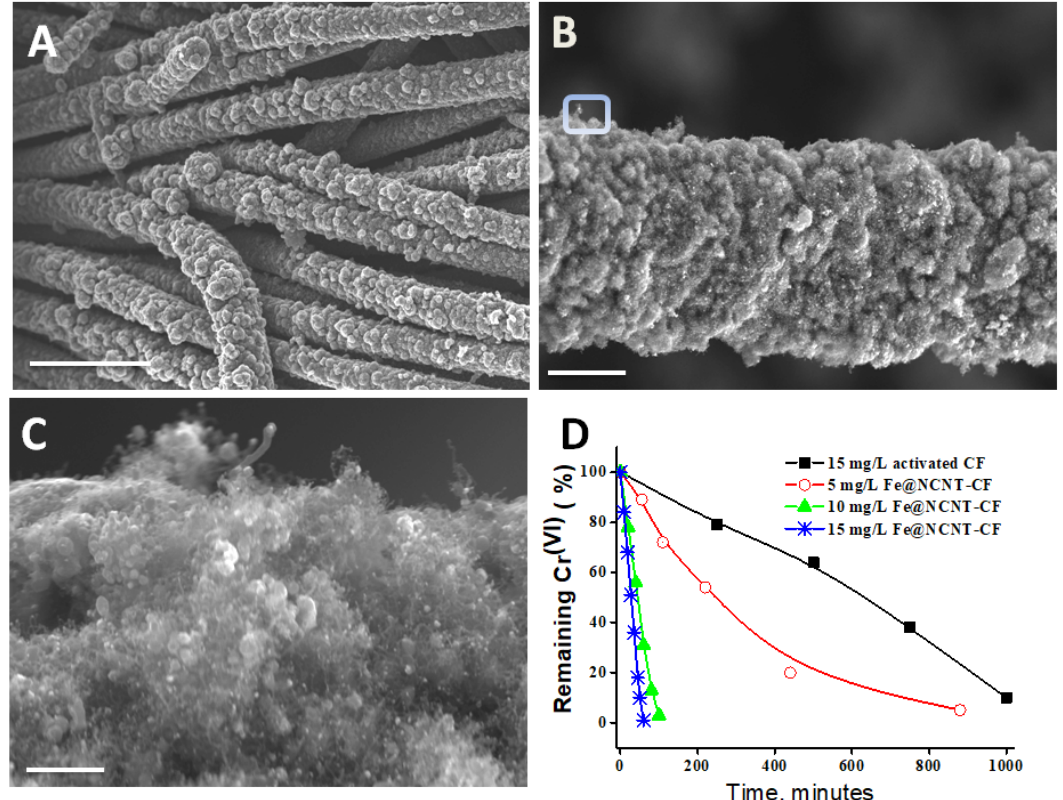
Figure 4. ( A – C ) Representative SEM micrographs at increasing magnifications of DABCO-derived nitrogen-doped carbon nanotubes grown on carbon fibers using an iron catalyst. Scale bars are ( A ) 25 µ m; ( B ) 4 µ m and ( C ) 500 nm. ( D ) Adsorption isotherms of hexavalent chromium on Fe@NCNT-CF nanostructures at various concentrations.